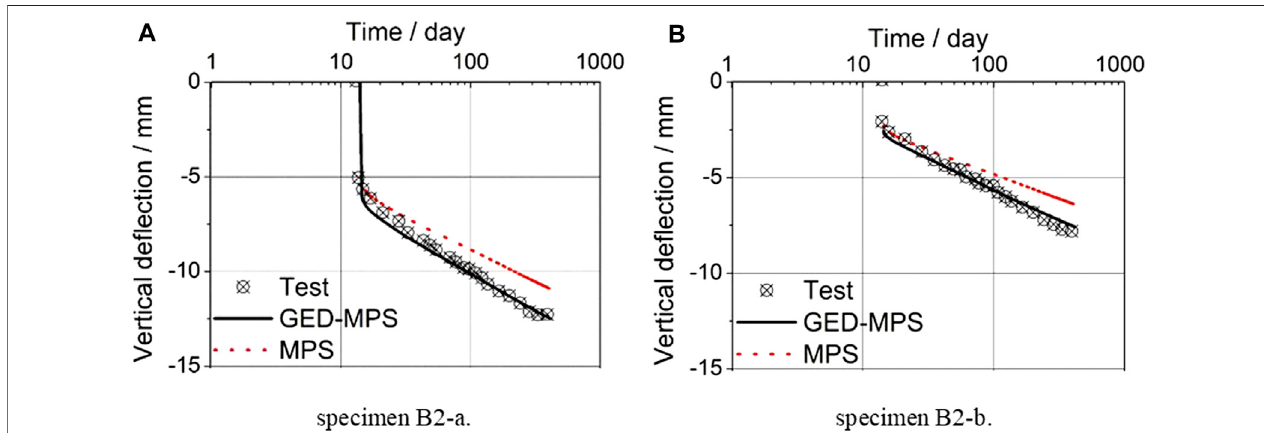
FIGURE 10 | Experimental and numerical de fl ections w/wo concrete cracking.